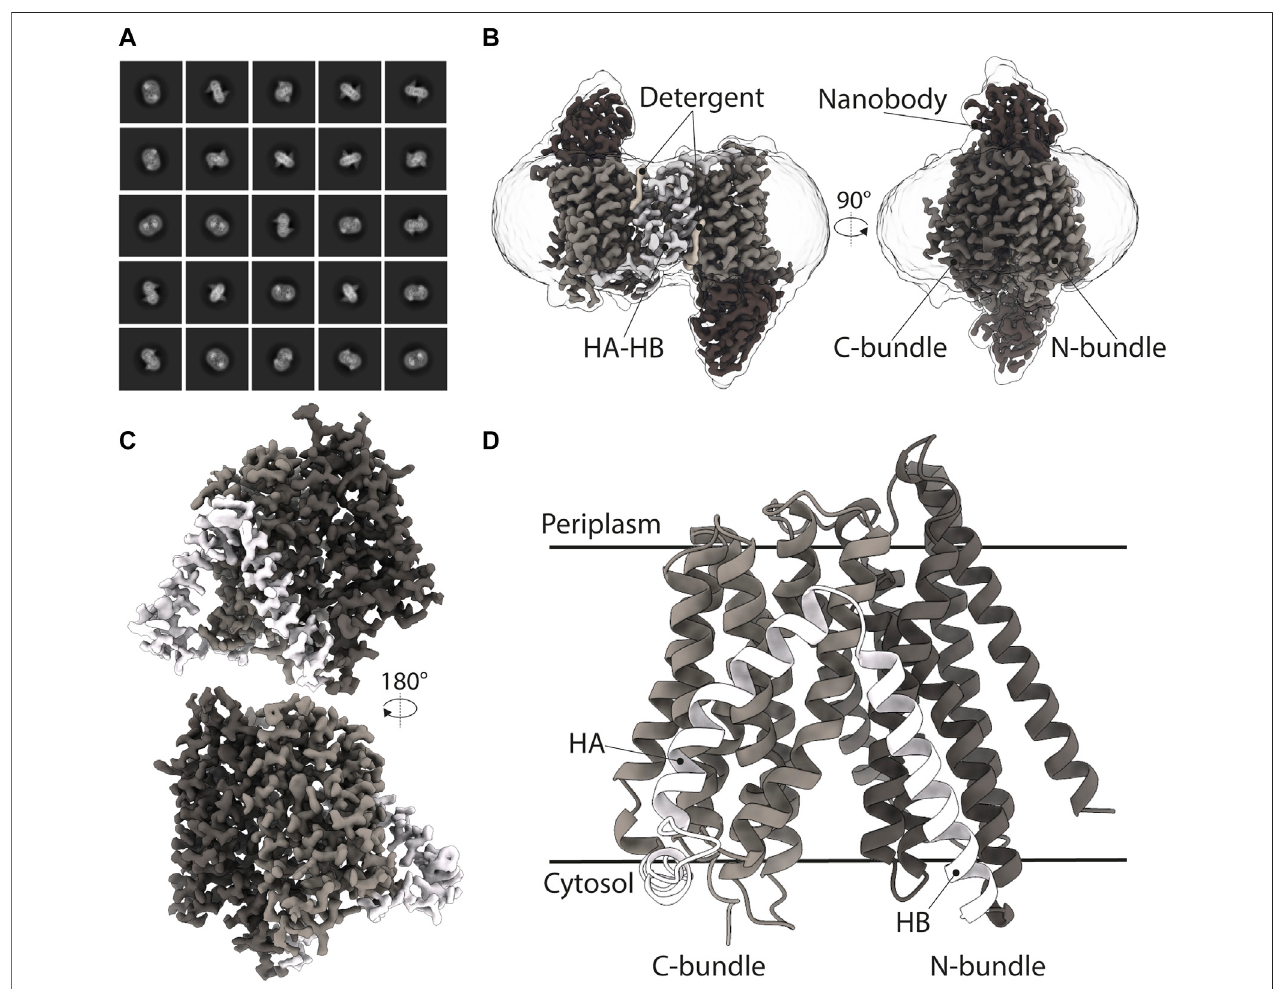
FIGURE 3 | Cryo-EM structure of DtpC-Nb26. (A) Representative 2D class averages of the dimeric population. (B) 3D reconstruction of the DtpC-Nb26 inverted dimer used for local focused re fi nement on one copy of the transporter, shown in (C) . (D) Atomic model of DtpC displayed as ribbon diagram. The different structural elements